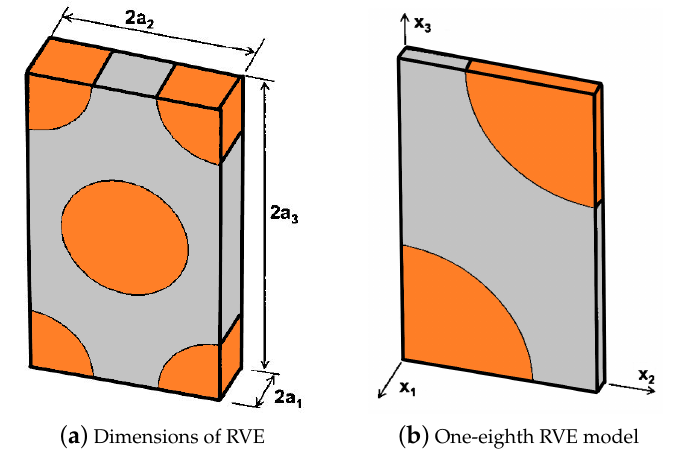
Figure 4. The implemented RVE with dimensions in the FE